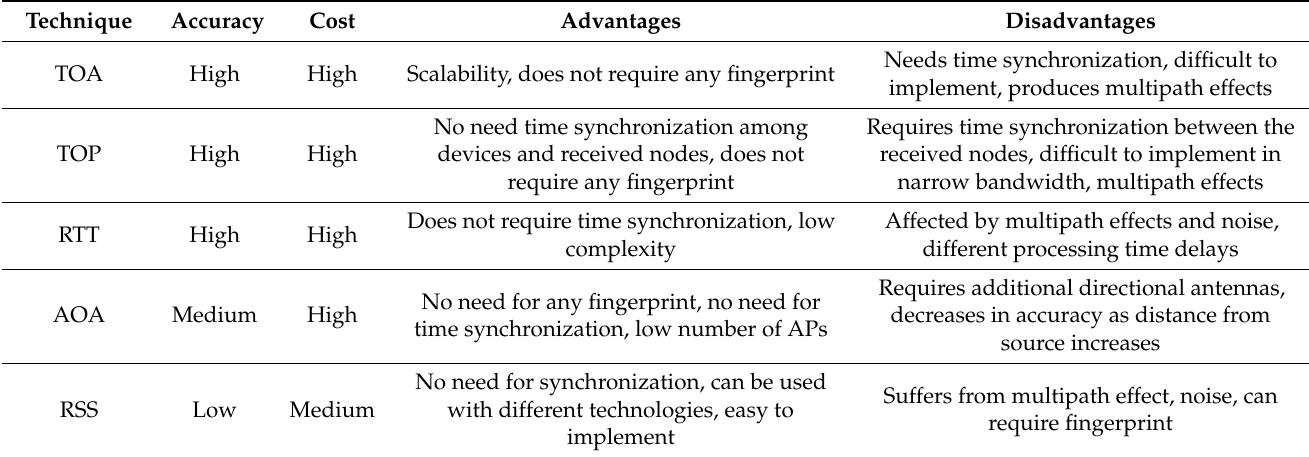
Table 2. Comparison of signal measurement